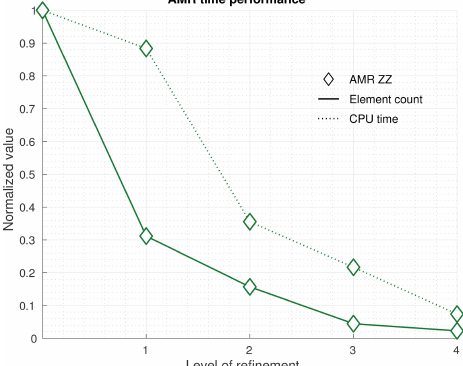
Figure 9. Number of elements and CPU time for AMR meshes us- ing the ZZ error estimator (AMR ZZ). The number of elements and CPU time are normalized by the respective values of the uniformly refined meshes. The normalized CPU time curve rep- resents the AMR savings, while the difference between the two curves represents the adaptive mesh procedure cost. Mesher used: Bamg. The thresholds for element/group used in the AMR ZZ are, respectively, (cid:15) max τ,e = 0 . 64 (cid:15) max τ and (cid:15) max τ,g = 0 . 32 (cid:15) max τ for L1,